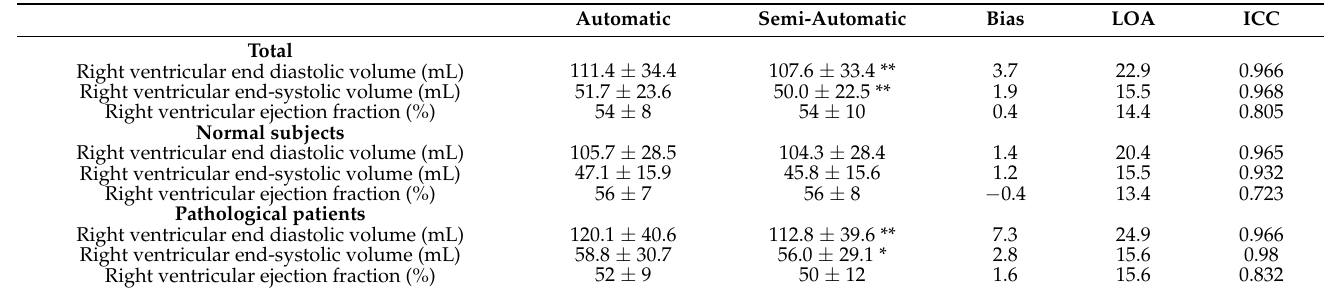
Table 2. Comparison between 3DE RV parameters evaluated with automatic and semi-automatic methods.